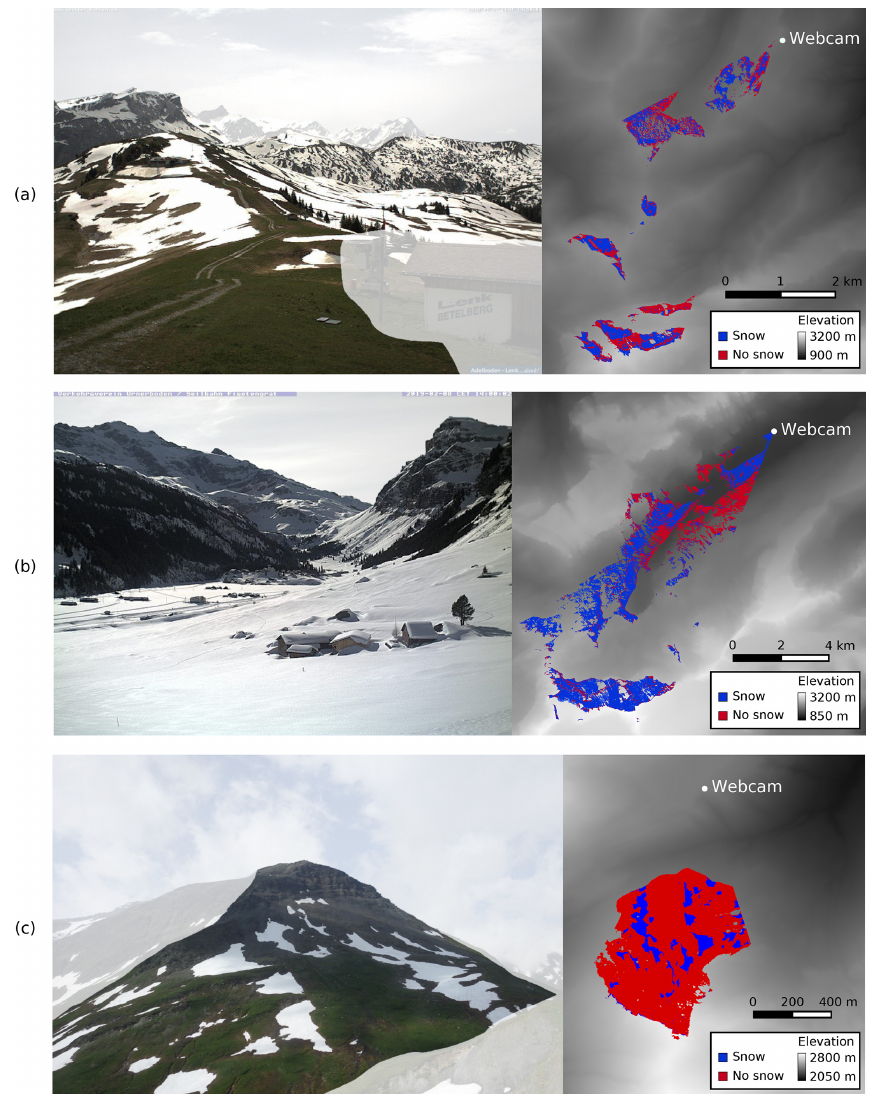
Figure 11. Example webcam images and resulting snow cover maps of three webcams: (a) Lenk Betelberg (© Skiregion Adelboden-Lenk), (b) Urnerboden (© Verkehrsverein Urnerboden, Seilbahngenossenschaft Urnerboden-Fisetengrat), and (c) Blauberg Furka Pass (© Armin Rist, Institute of Geography, University of Bern). Snow is classified using the method proposed by Salvatori et al. (2011). The white transpar- ent layer on the webcam images shows the masked regions. The grayscale values of the snow cover maps show the swissALTI 3D elevation values of the area that is not visible from the webcam’s location (©